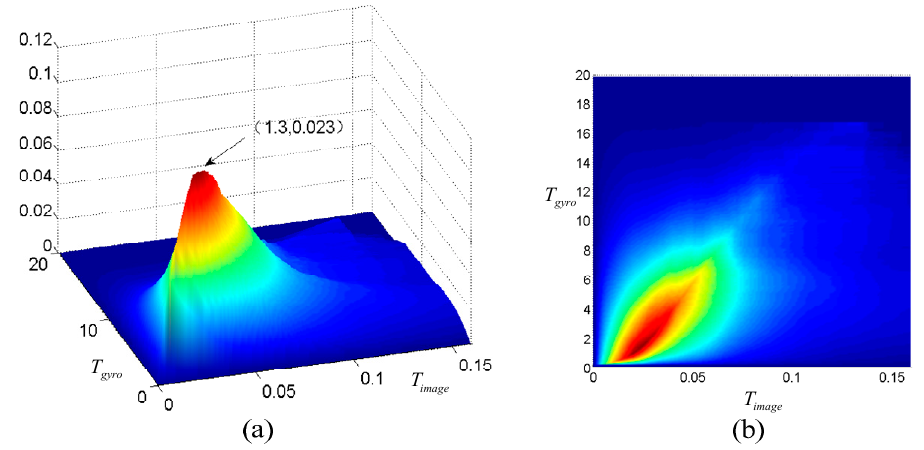
Figure 6. Threshold determination ( a ) 3D view; ( b ) 2D view.